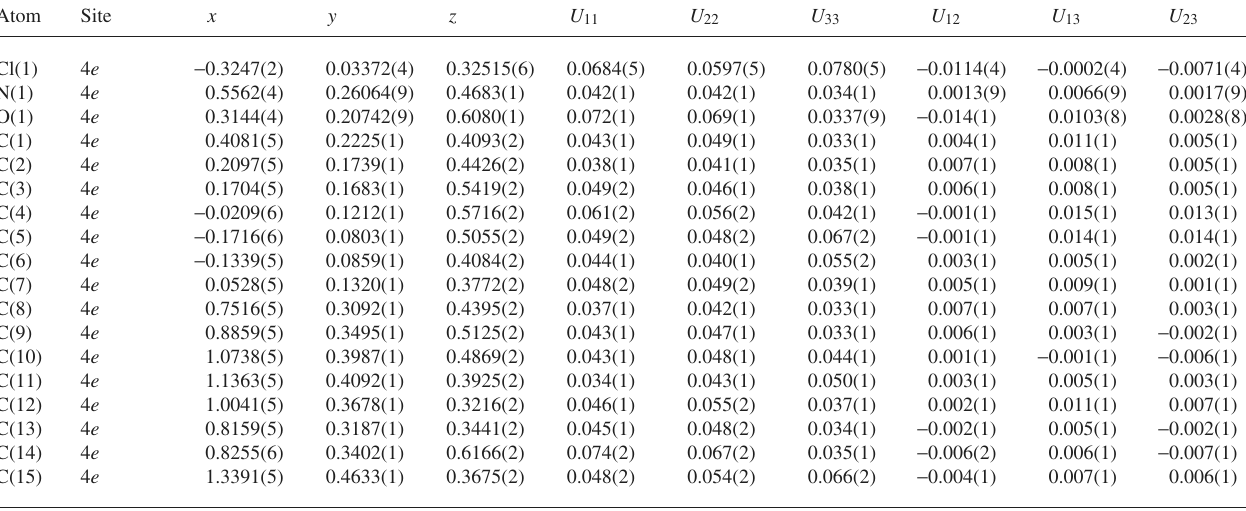
Table 3. Atomic coordinates and displacement parameters (in Å 2 )